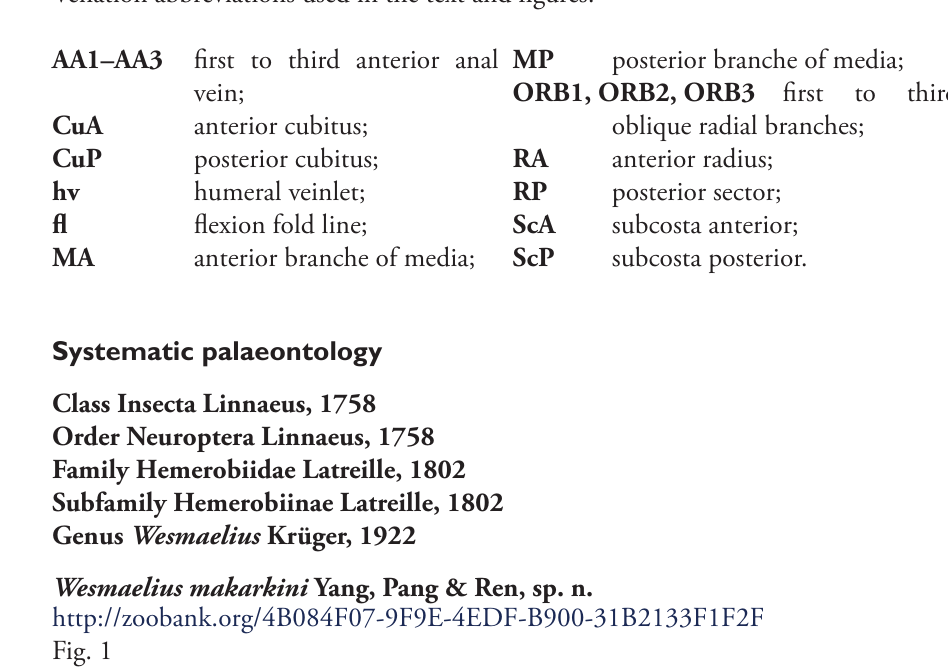
Holotype. CNU-NEU-QZ2017001 (holotype), a complete forewing (Fig. 1). Diagnosis. Forewing with transparent spots on veins, and dark spots on the gradu- ate crossveins, darker pigmentation along wing margin, subcostal veinlets, and longitu- dinal veins with dark intervals or dots. MA and MP pectinately forked, 2m-cu located at the fork of MA and M, the crossveins of the third gradate series more oblique. Description. Holotype CNU-NEU-QZ2017001. Only forewing preserved. Forewing oval, 8.31 mm long, 3.17 mm wide. Trichosors prominent, along the entire wing margin. Setae distinct, scarce on the veins and dense on the margin. Costal space relatively broad, dilated basally. Humeral veinlet recurrent, with two pectinate branches. Presumable ScA present. Majority of subcostal veinlets branched once, several basal vein- lets branched twice, with no crossveins between them. Subcostal space moderately broad, with two prestigmal sc-r crossveins: basal 1sc-r and distal 3sc-r. Posterior trace of RA forked apically, with two distal branches. One RA branch forked once, the other twice. RP with three branches (ORBs) originated from RA; ORB1with two pectinate branches between 3r-m and 4r-m, all with distal forks; ORB2 dichotomously forked between the third and fourth gradate series of crossveins, each branch dichotomously forked; ORB3 forked be- tween the second and third gradate series, with two dichotomously forked branches. M appear to be fused basally with R. M forked at 2m-cu; MA, MP configuration similar, parallel for a long distance, then each with two pectinate branches between the third and fourth gradate series. The second branch of MP dichotomously forked. Forewing with three m-cu crossveins. Crossvein 2r-m present and positioned distally to crossvein